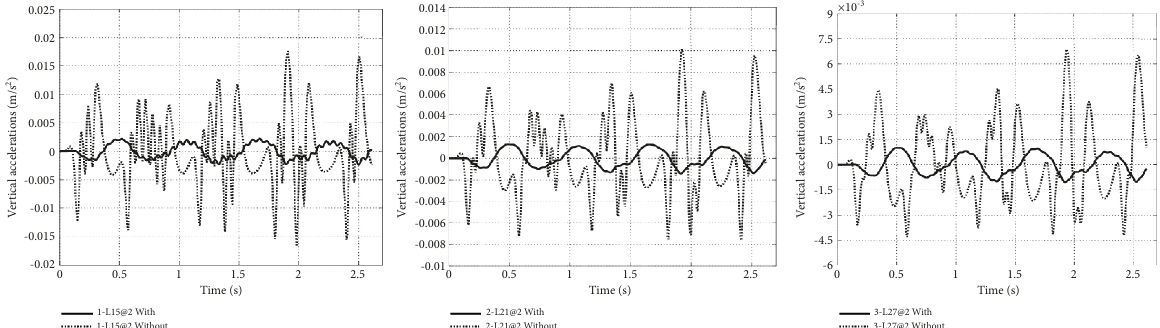
Figure 12: Vertical vibration isolation of the vibration isolation slab system 15m, 21m, and 27m from the